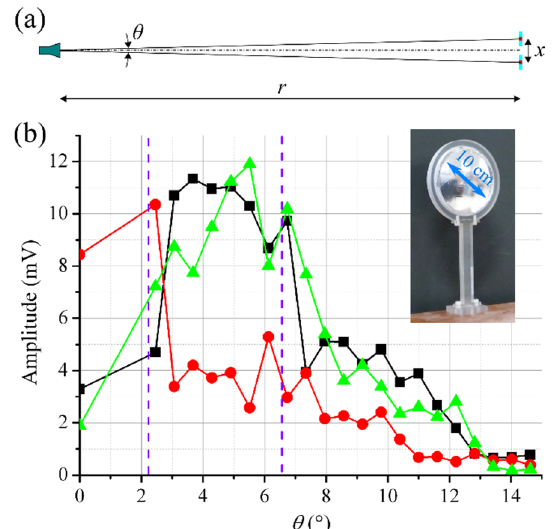
Figure 4. ( a ) A disposition scheme of the imaging system and the reflectors in an experiment of angular resolution study. A photo of the reflector is in the inset. ( b ) The amplitude of the BF signals of the left (black), the central (red), and the right (green) receiving elements in dependence on the angle between the reflectors ( θ ). The order of the receiving elements corresponds to Figure 3. The vertical violet lines in the graph are placed at the angles at which the reflected RF power falls onto boundaries of the receiving elements.